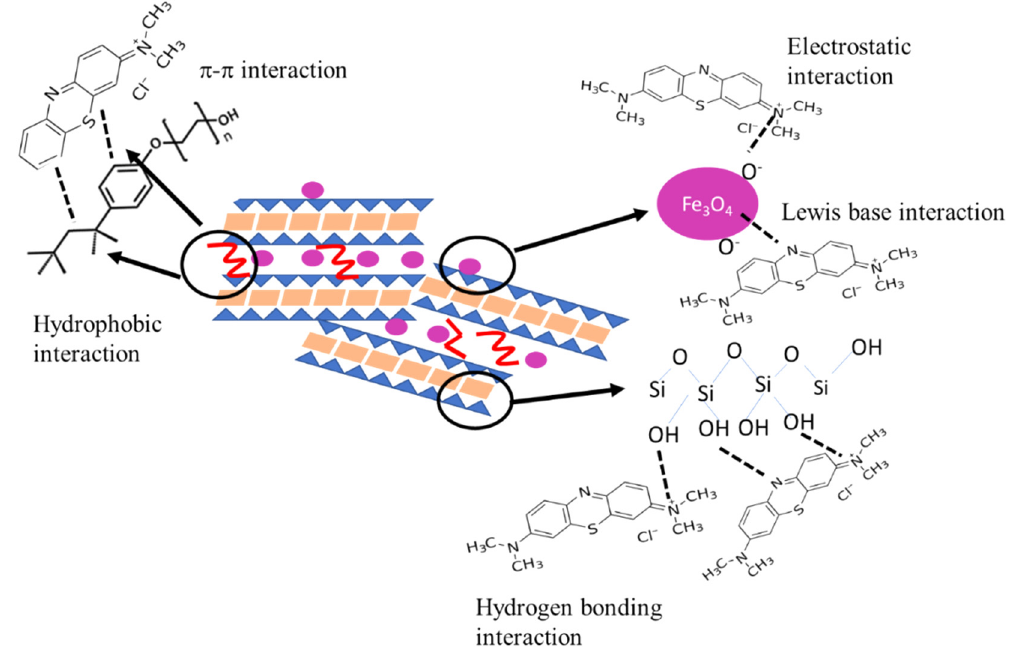
Figure 5: Montmorillonite ( Mt. )- supported iron shifts base complexes as a